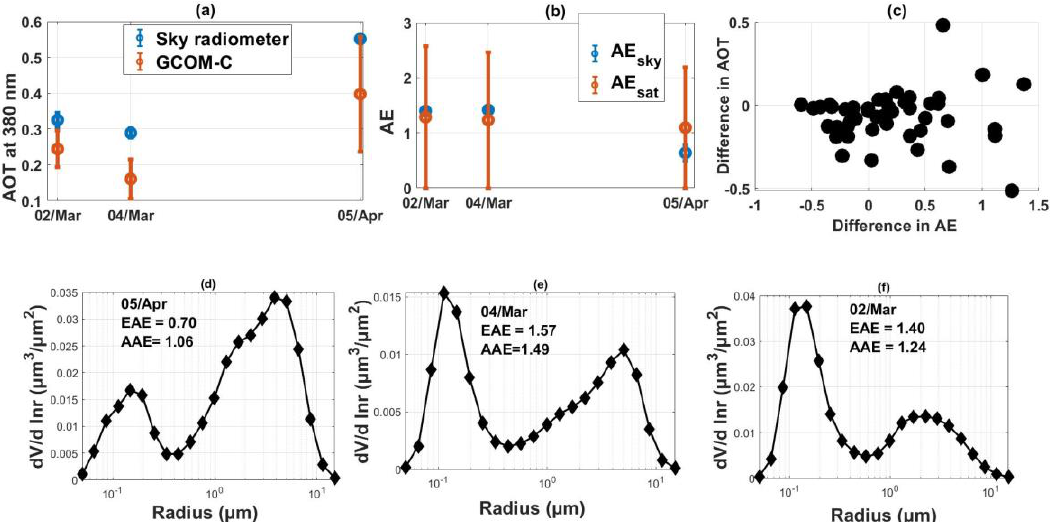
Figure 6. (top panel) ( a ) The sky radiometer and GCOM-C AOT at 380 in Chiba on March 2 and 4 and April 5. The coincident days were selected based on the AAE, EAE, and volume size distribution data. ( b ) The corresponding sky radiometer and GCOM-C AE values on March 2 and 4 and April 5. The sky radiometer and GCOM-C AE are denoted as AE sky and AE sat , respectively. ( c ) The difference between the sky radiometer and GCOM-C AOT was plotted as a function of differences in AE sky and AEs att . (bottom panel) The aerosol volume size distribution from the coincident AERONET observations in Chiba on ( d ) April 5, ( e ) 4 March, and ( f ) March 2. The example days were chosen based on the AAE and EAE values.